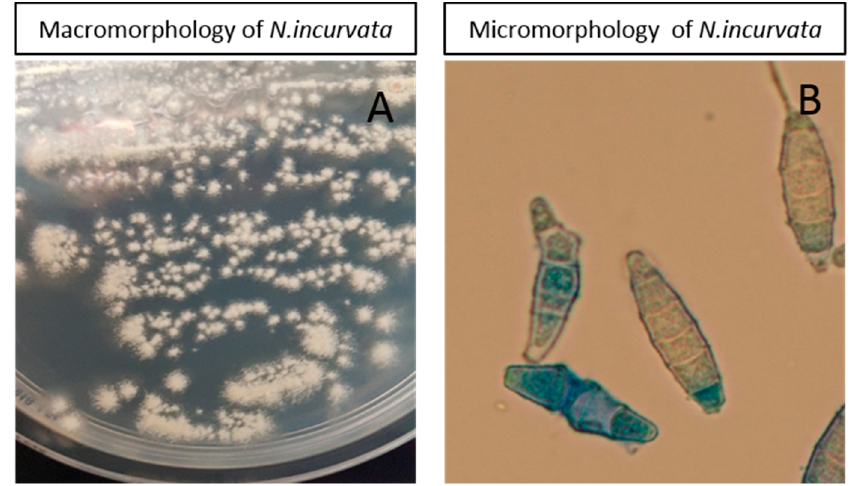
Figure 3. Macromorphology ( A ) and micromorphology ( B ) of the N. incurvata strain isolated in the study.